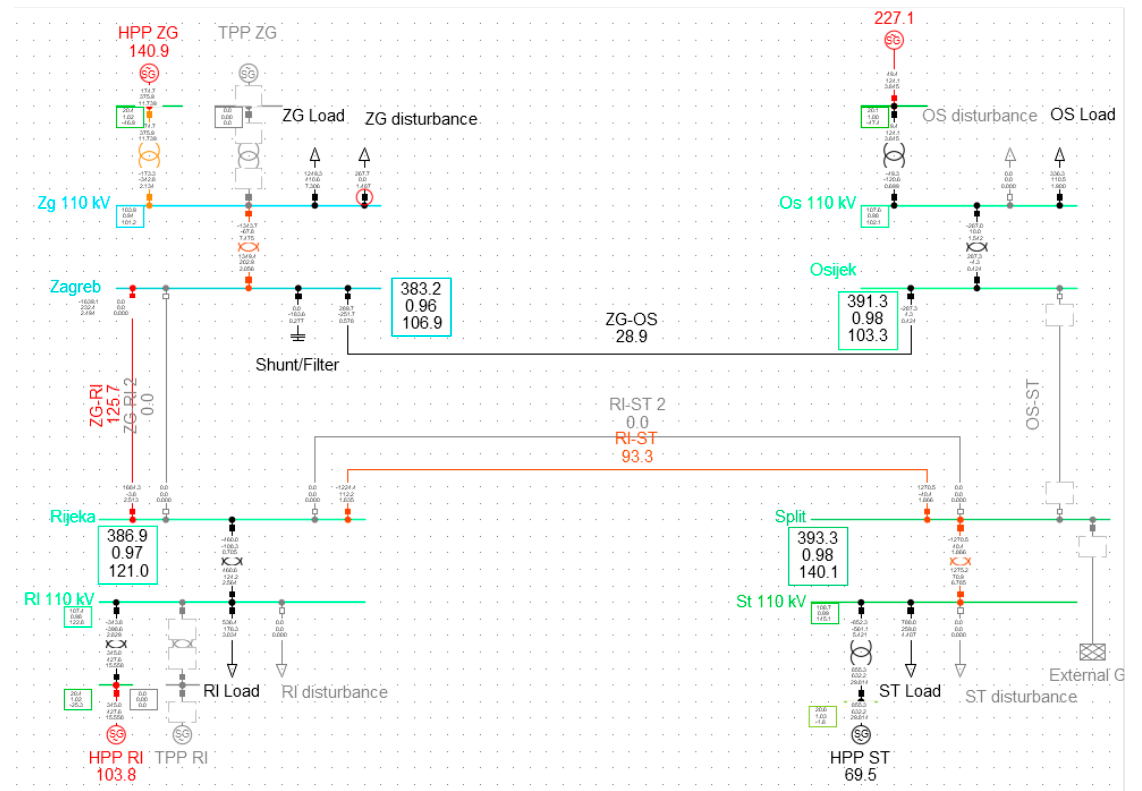
Figure 10. Line loadings and voltage profile without increasing transmission capacities between north and south.